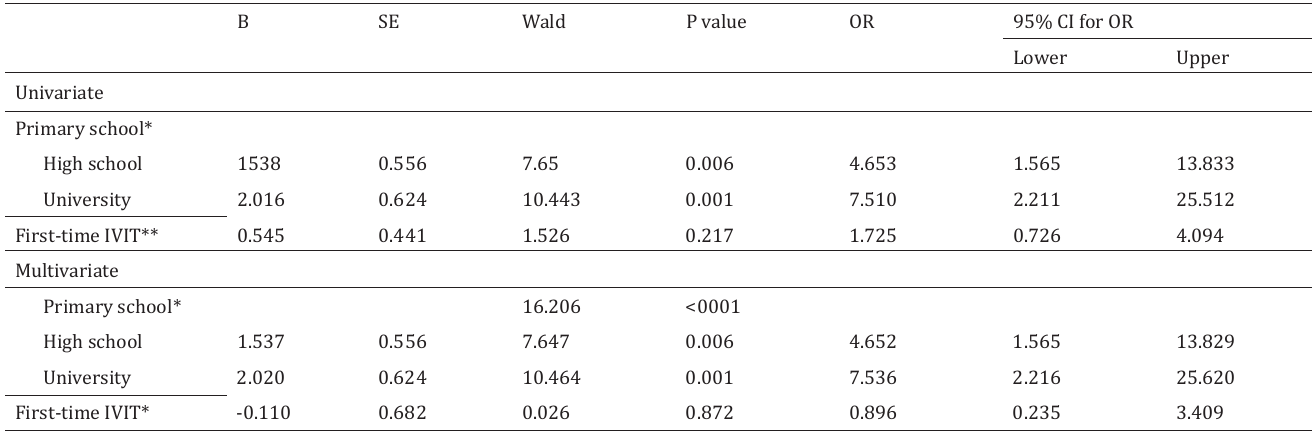
Analysis of simpler CFs based on ELs in first-time and multiple IVIT recipients using logistic regression